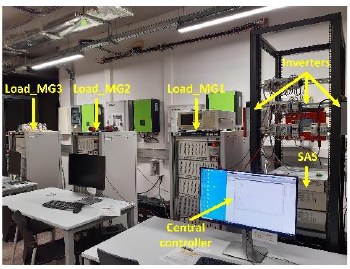
Figure 9. Laboratory experiments ’ configuration.